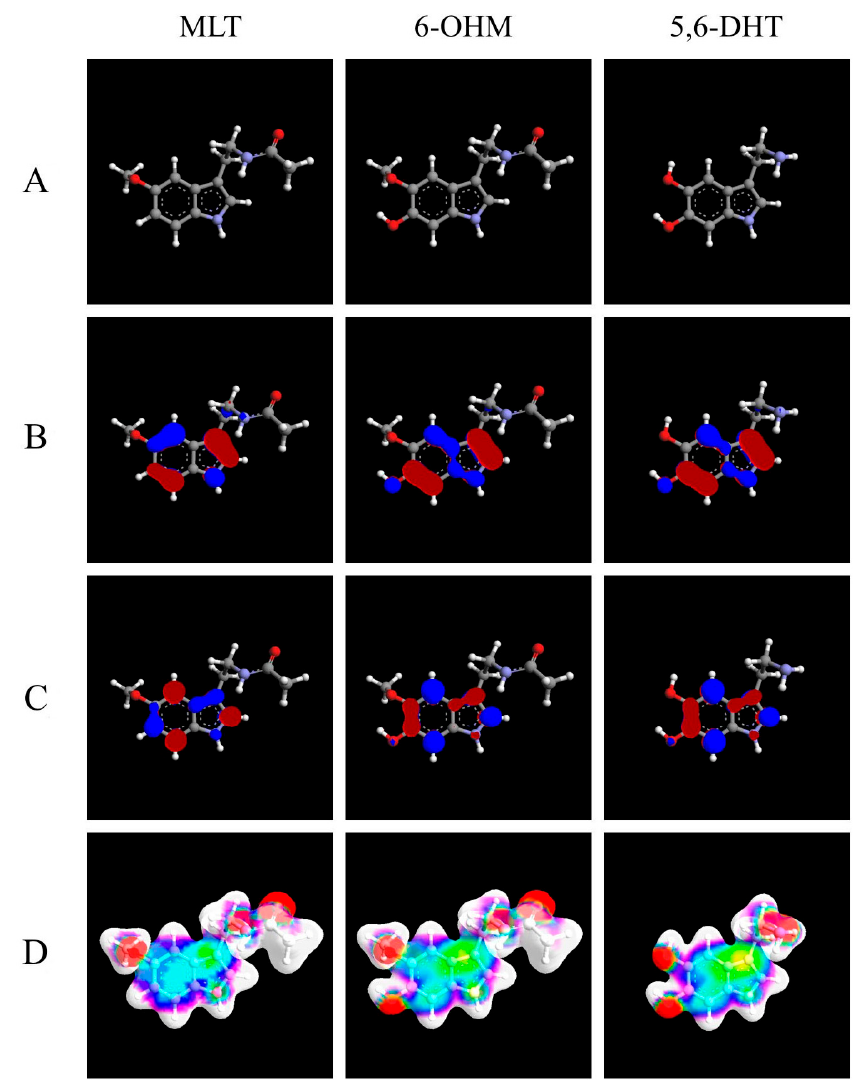
Figure 1. 3D molecular structures of melatonin (MLT), of 6-hydroxymelatonin (6-OHM), and of 5,6-dihydroxytryptamine (5,6-DHT). ( A ) 3D molecular structure to note the distances between 2 oxygen atoms of 6-OHM and 2 phenolic hydroxyls of 5,6-DHT, respectively 2.77 and 2.82 Ångström